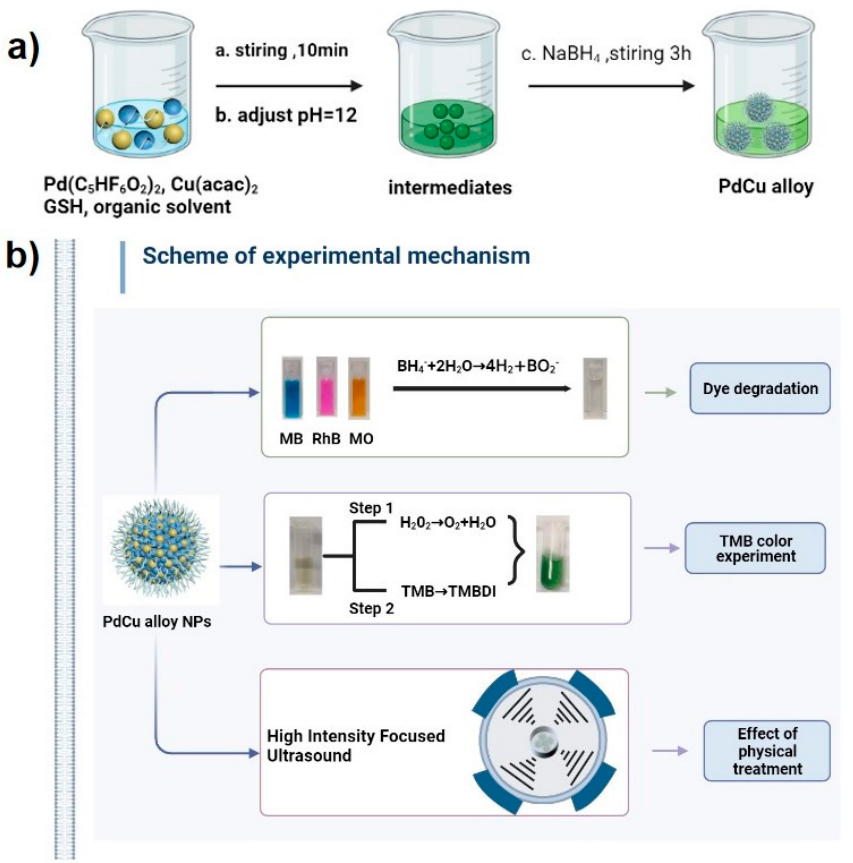
Scheme 1. ( a ) schematic illustration of the formation process of Pd-Cu alloy NPs; ( b ) schematic illustration of super-hydrophilic Pd-Cu alloy NPs as highly active and biocompatible catalyst for dye degradation reactions.